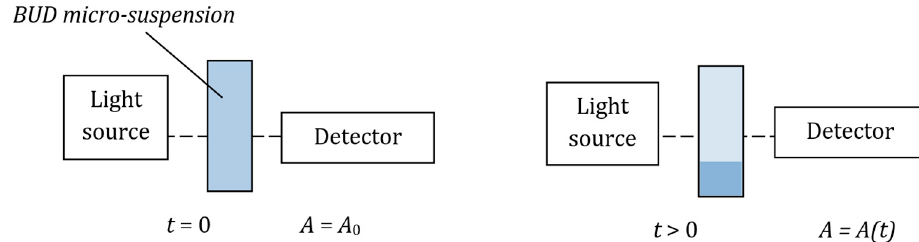
Figure 1. The principle of the spectrophotometric measurement of micro-suspension stability. A denotes the light absorbance: A(t) < A 0 .